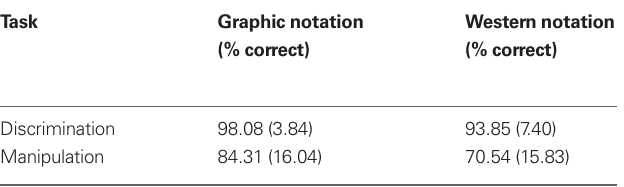
Table 9 | Melodic discrimination and manipulation performance with notation for session 1 ( ±